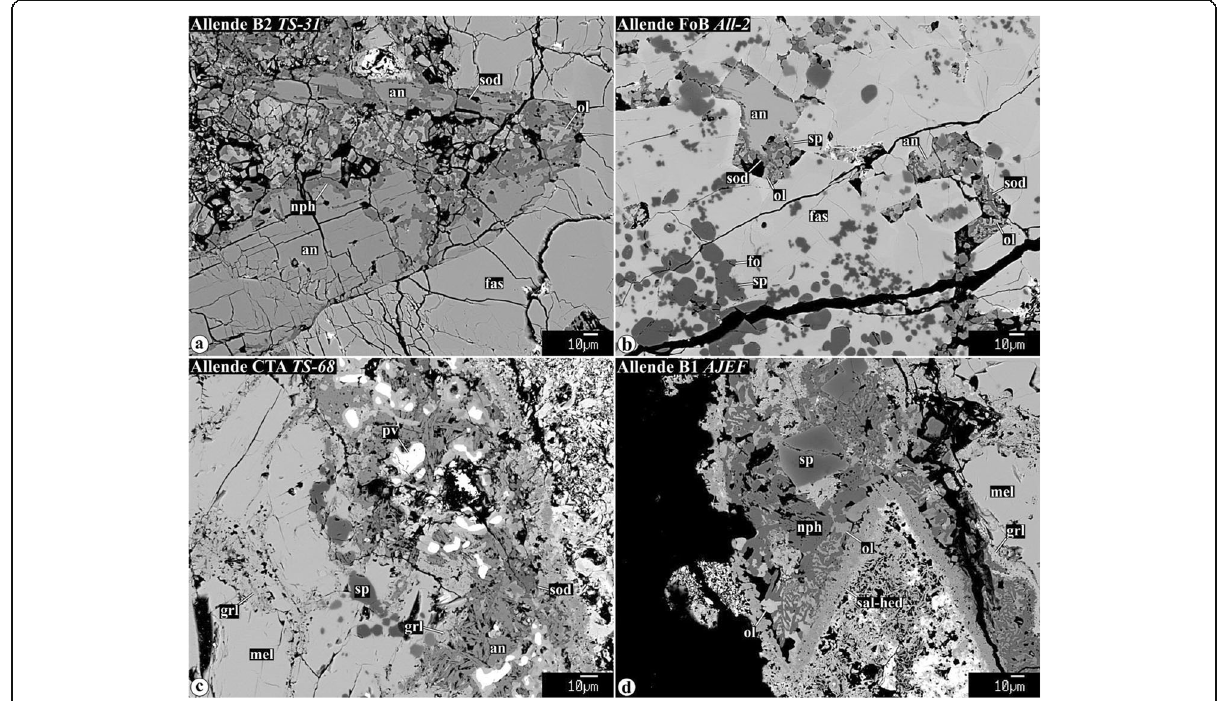
Fig. 6 Backscattered electron images primary anorthite ( a , b ) and secondary anorthite ( c , d ) in the peripheries of the Allende coarse-grained igneous CAIs. Both types of anorthite are replaced by nepheline, sodalite, and ferromagnesian